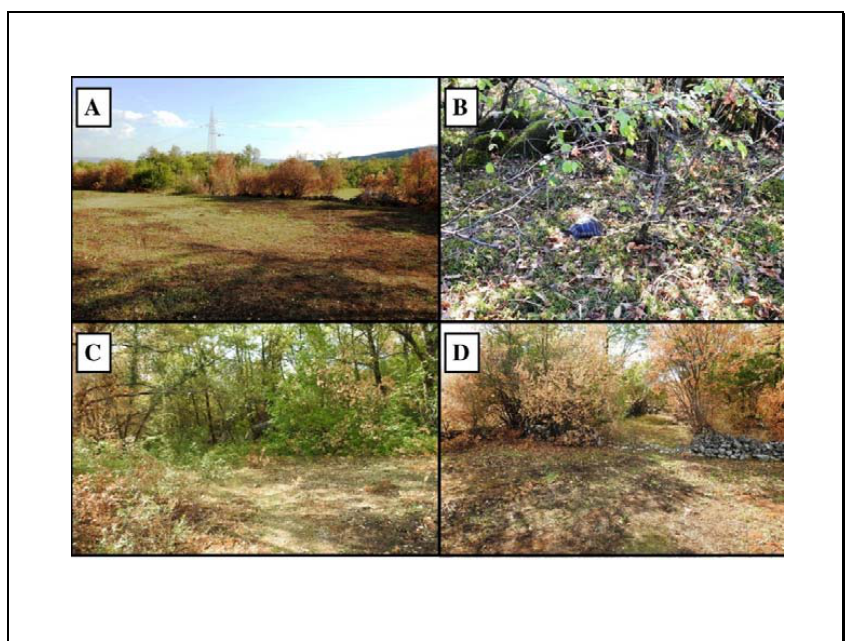
Figure 3. Examples of key areas for thermoregulation in a low ‐ cost thermal environment: ( A ) open sunlit area where maximum temperatures were found; ( B ) tortoise moving through partial shaded/sunlit area; ( C , D ) show examples of low ‐ cost habitat in terms of thermoregulation for a reptile with small distances between sunlit and shaded areas.